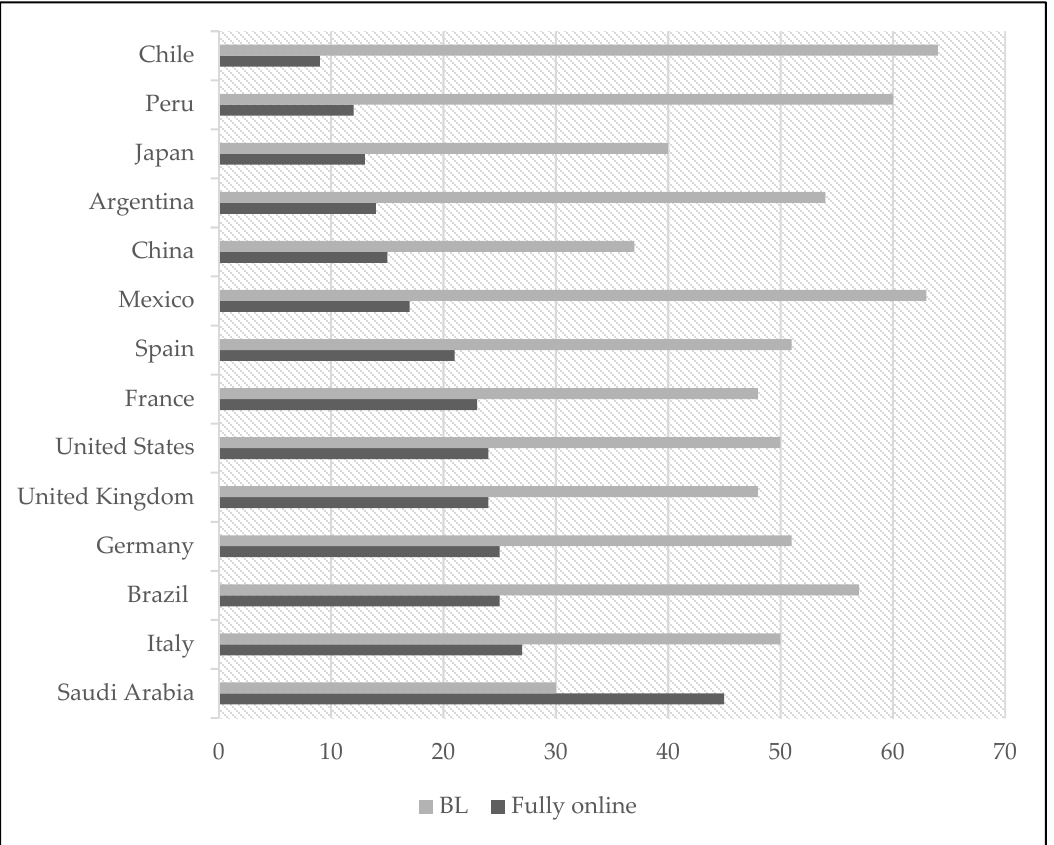
Figure 1. Sample of responses from the survey about the teaching modalities that will be used in the future for higher education.